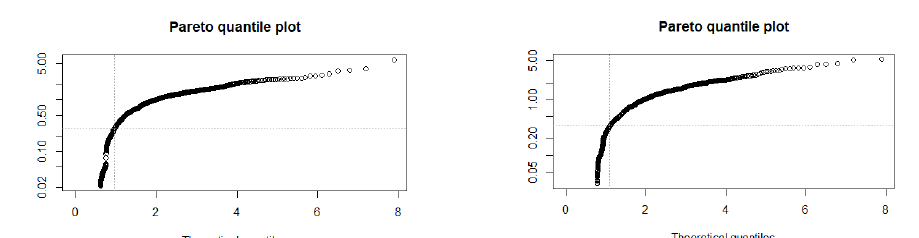
Figure 7. FTSE/JSE Mining Index Returns Pareto quantile plot of positive (left) and negative (right) standardized residuals